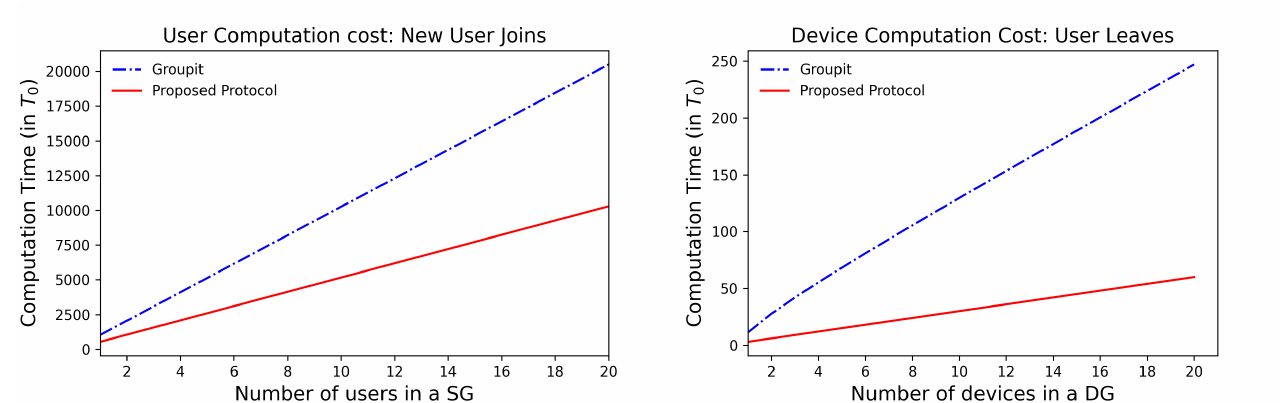
Figure 14. The figure shows the total computational load for all users under GroupIt and the proposed protocol versus the number of users in a SG for the case when a new user joins. small values of N , our proposed protocol outperforms GroupIt. This advantage increases linearly in N .